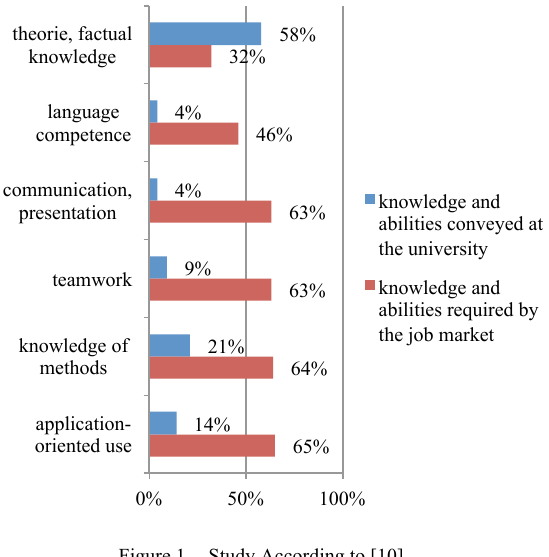
Figure 1. Study According to [10]